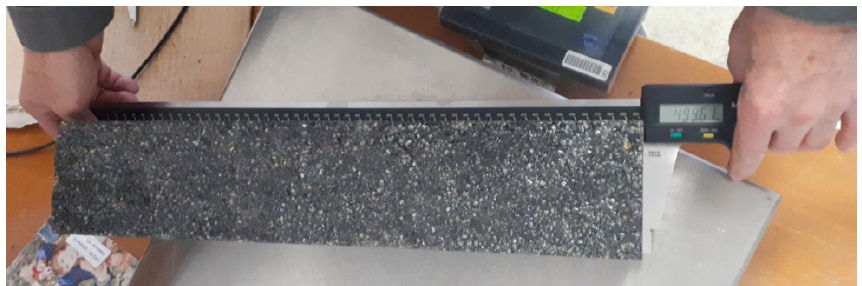
Figure 5. Control of test samples.